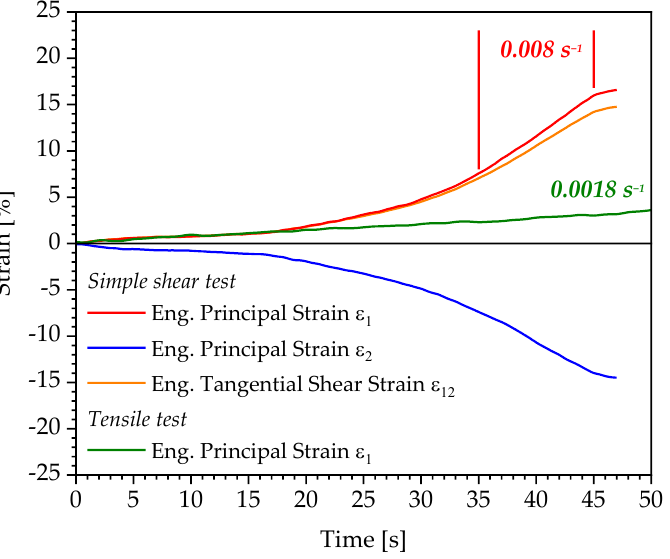
Figure 15. Time-dependent curves of the strains within a quasi-static simple shear and tensile test on the example of the polyurethane system Neukadur ® .